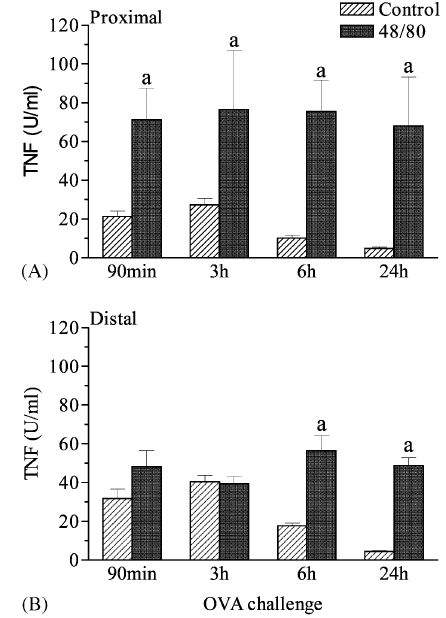
FIG. 3. Effect of invivo treatment with compound 48/80 on the TNF- a activity in supernatants from proximal (A) and distal (B) tracheal segments after OVA challenge. Procedures as in Fig. 2. The control group consisted of rats treated with phosphate-buffered saline. The data represent mean 9 / stan- dard error of the mean from four to 11 experiments. a, p B / 0.05 in comparison with the respective control